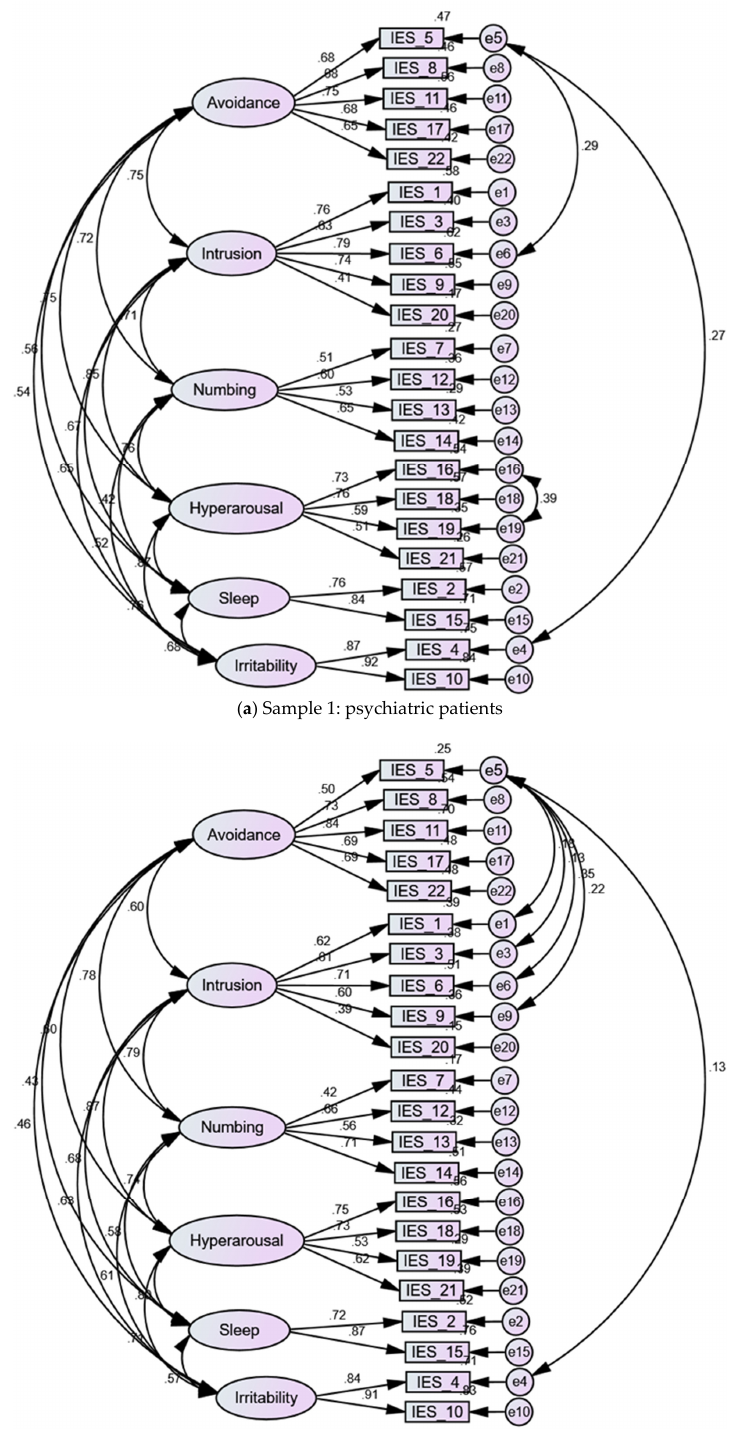
Figure 1. Six-factor structure of the Arabic version of the Impact of Event Scale-Revised (IES-R) among psychiatric patients ( a ) and the general public ( b ). All items had moderate to strong loadings (>0.3) on the corresponding factors as indicated by values on the arrows connecting the factors to the items of the IES-R. The values on the arrows associating the factors of the IES-R reflect considerable inter-factor correlations. The fit of this model was improved by correlating the error term of item 5 with other items in both samples as well as the error terms of items 16 and 19 in the psychiatric patient sample.